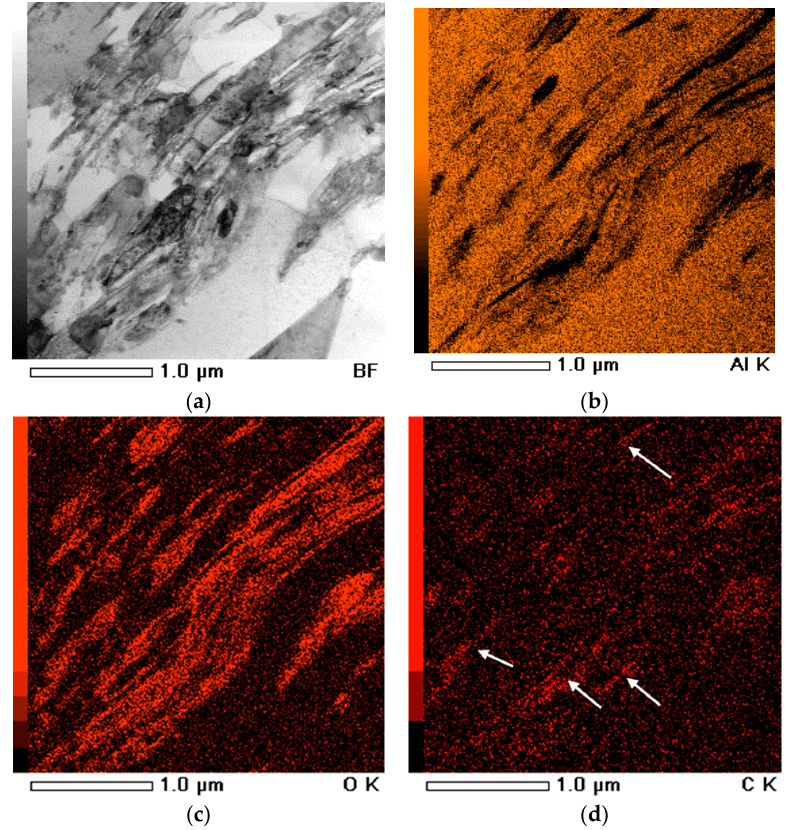
Figure 6. Combination of TEM and EDS analyses on composite CNT–Al sintered at 900 K. ( a ) Bright field TEM image. ( b ) Al element distribution. ( c ) Oxygen (O) element distribution. ( d ) Carbon (C) element distribution.